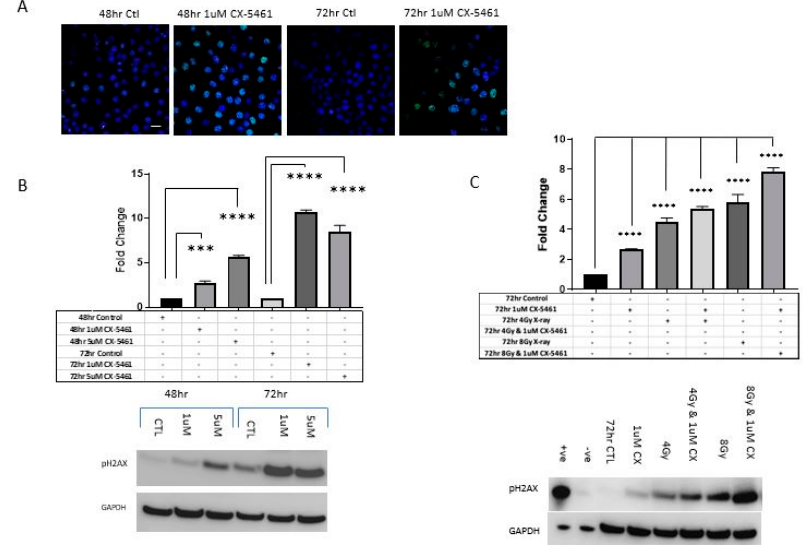
Figure 6. CX-5461 exposure induced DNA damage. CaSki cells were treated with 1 µM CX-5461 over 72 h and visualized using confocal microscopy, DNA damage was marked by γ H2AX staining ( A ) (anti-rabbit γ H2AX 1:1000 (green) DAPI (blue), distinct green foci could be seen in CX-5461-treated samples,